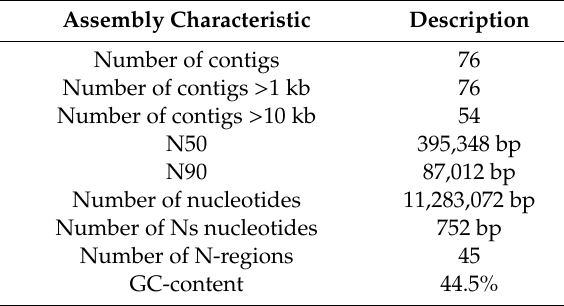
Table 1. Details of B. naardenensis CBS 7540 genome